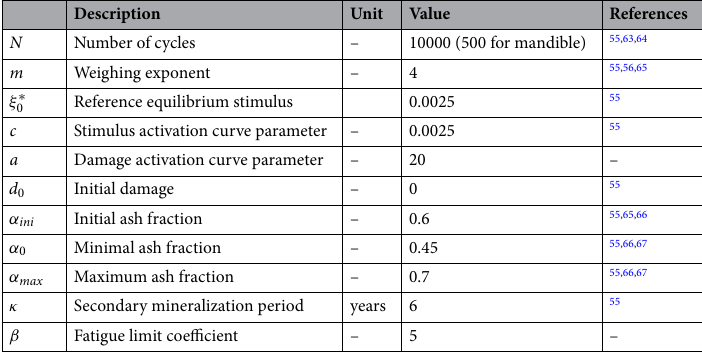
Table 3. Values and description of the mechanical